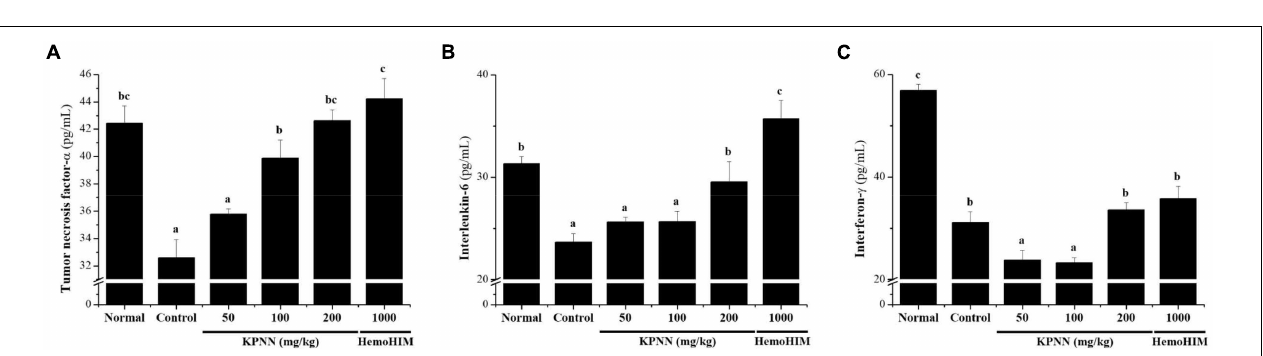
FIGURE 7 | Effects of KPNN on immune cell numbers in Cy. Wistar rats were treated with saline, cyclophosphamide (Cy; 5 mg/kg/day), oral KPNN (0, 50, 100, and 200 mg/kg/day), or oral HemoHIM (1,000 mg/kg/day) once daily for 4 weeks. Whole-blood samples were collected for analysis. The levels of (A) total WBCs, (B) lymphocytes, (C) granulocytes, and (D) mid-size cells in the blood samples were determined using a Hemavet 950 system. All data are expressed as mean ± SEM of three independent experiments, p < 0.05 vs. control group ( n = 10). Bars labeled with different superscript numerals indicate p < 0.05.